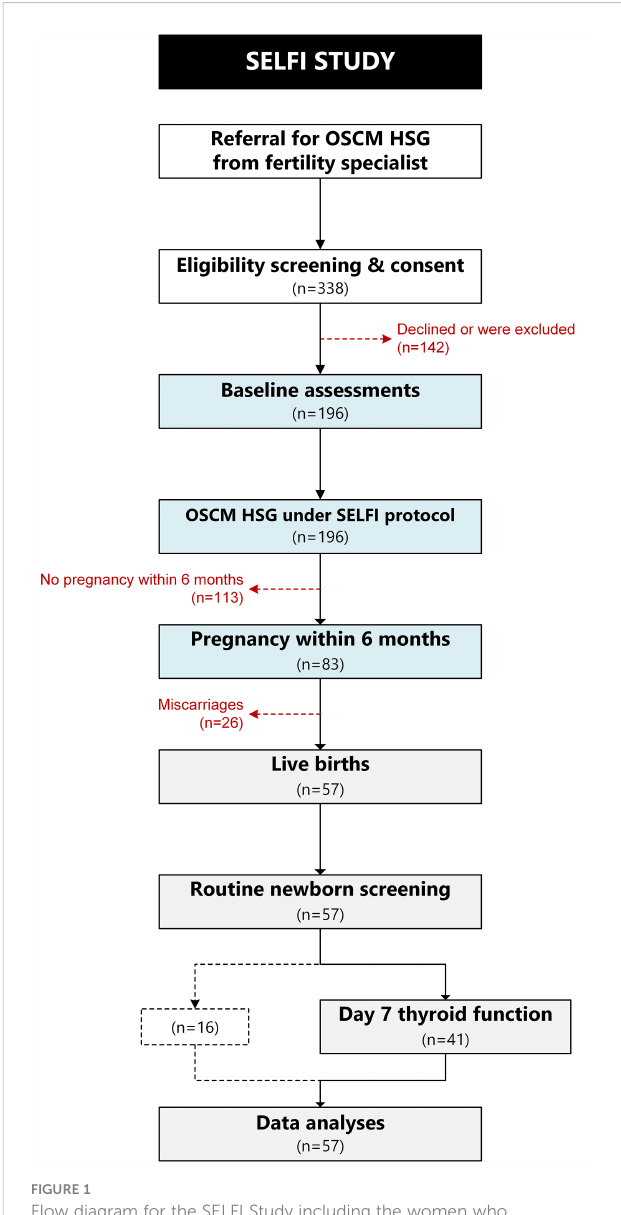
underwent oil-soluble contrast medium (OSCM) hysterosalpingography (HSG), those who became pregnant, and the subsequent number of newborns included in this study. Dashed black line indicates the newborns whose parents declined the Day 7 thyroid function